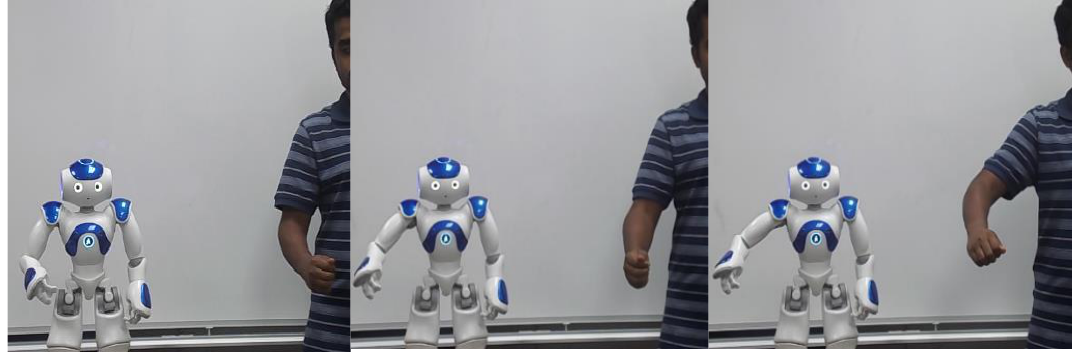
Figure 17: Arm position of human operator and NAO robot for diagonal reaching motion during teleoperation